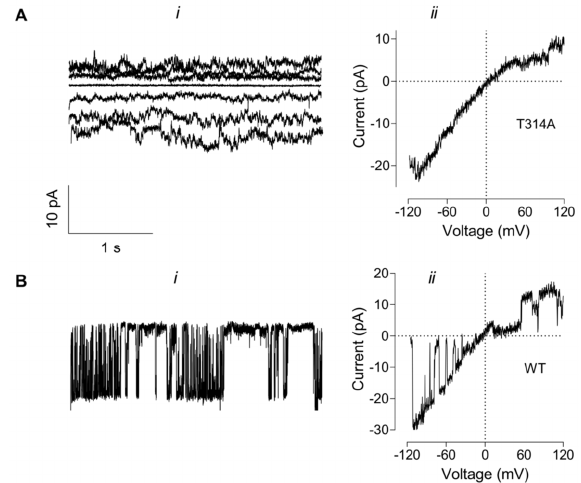
Figure 7. Membrane currents recorded in inside-out patches from the cells expressing T314A or WT KCNT1. ( A ). T314A KCNT1 current traces recorded in response to 3 s voltage steps ranging from − 60 mV to 60 mV (i) or a voltage ramp from − 120 mV to 120 mV (ii). ( B ). WT KCNT1 current trace recorded in response to 3 s voltage step to − 40 mV (i) or a voltage ramp from − 120 mV to 120 mV (ii). All traces were recorded using symmetrical K + (130 mM) and Na + (20 mM) concentrations in the bath and the pipette